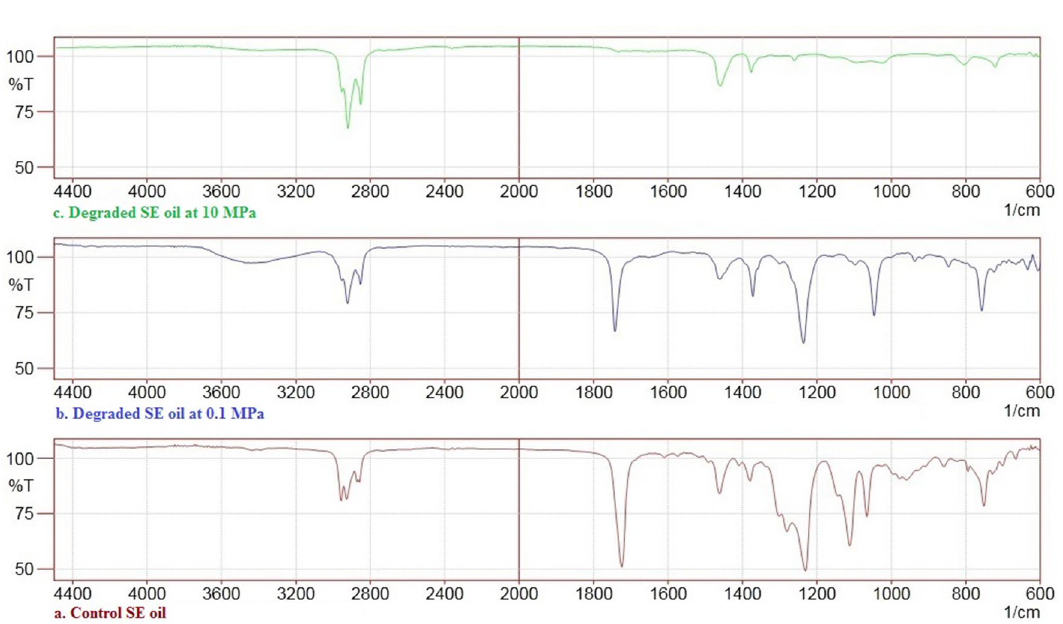
Figure 4. FTIR spectra analysis ( a ) SE oil, ( b ) degraded SE oil at 0.1 MPa and ( c ) degraded SE oil at 10 MPa pressure